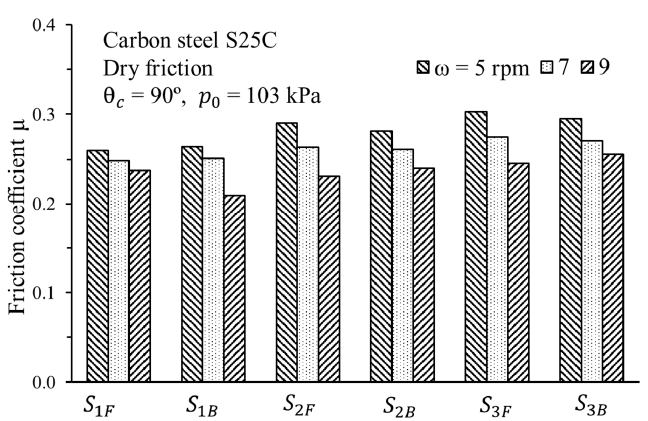
Figure 7. E ff ects of rotation speed on friction coe ffi cient under dry friction condition. Figure 7. Effects of rotation speed on friction coefficient under dry friction condition.